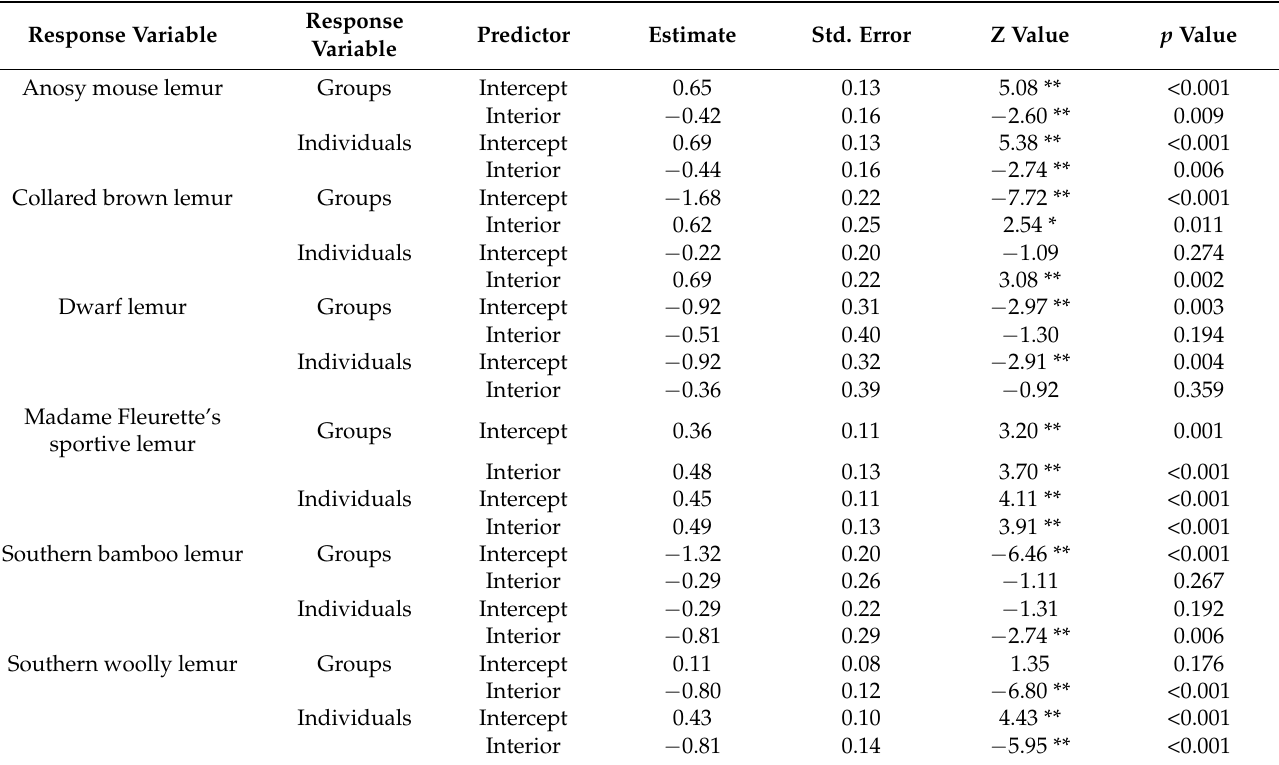
Table A3. Results of the Generalised Linear Models with the abundance of individuals or groups of different lemur species as response variable and edge vs. interior as